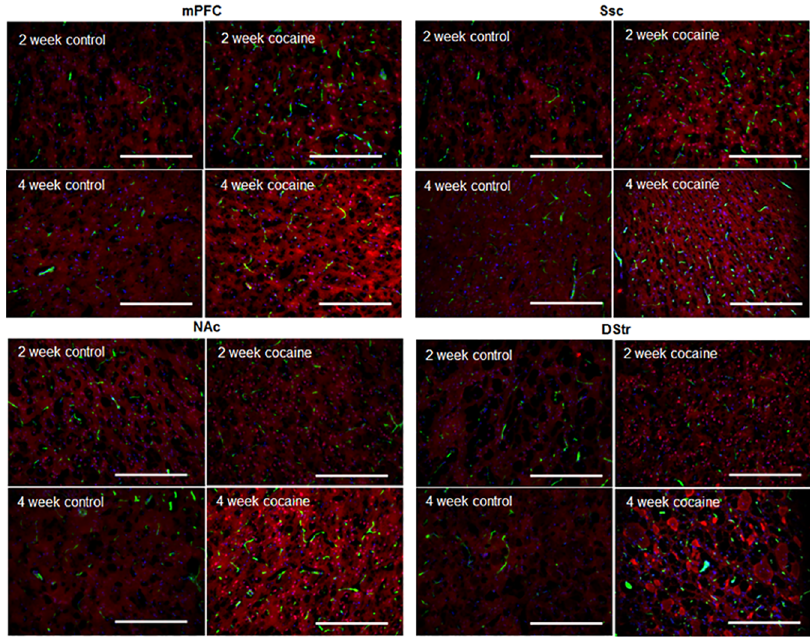
Fig 5. Representative images of VEGF and microvasculature co-localization within different brain regions. Scale bars stand for 100 μ m.